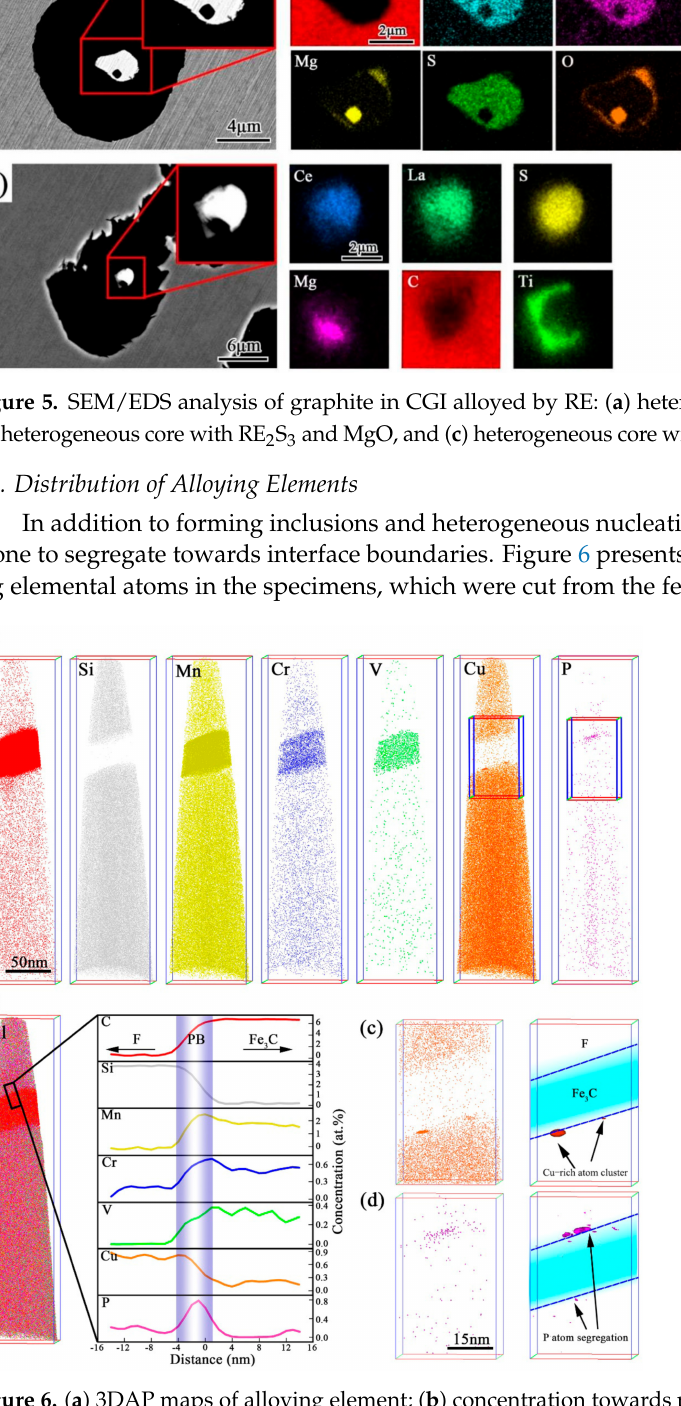
Figure 6. ( a ) 3DAP maps of alloying element; ( b ) concentration towards phase boundary; ( c ) 3.0 at.% isoconcentration surfaces of Cu atoms; ( d ) 0.3 at.% isoconcentration surfaces of P